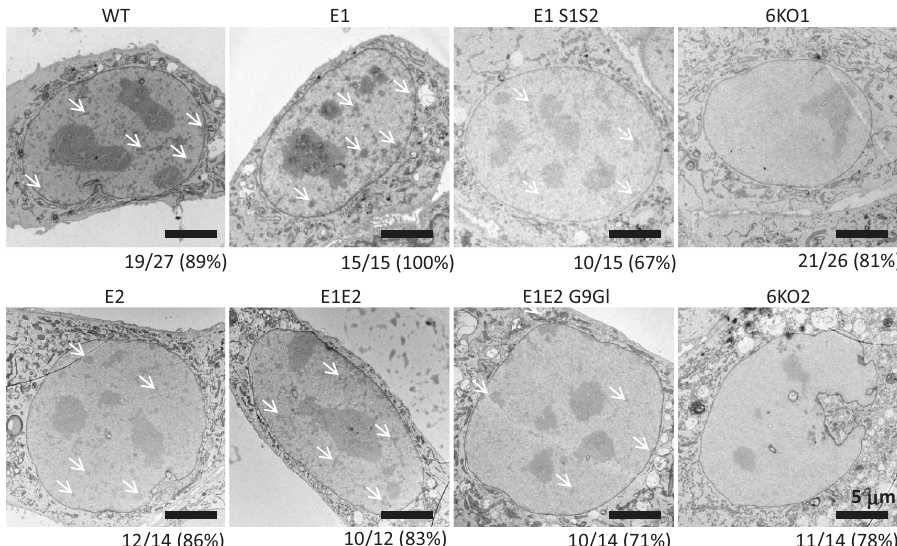
Fig. 7 Loss of electron-dense heterochromatin in MEF cells lacking all 6 SET-domain H3K9 KMT. Transmission electron microscopy (TEM) images of nuclei from compound H3K9 KMT mutants. Each panel shows a representative TEM image of a nucleus of the indicated H3K9 KMT mutant. White arrows point to electron-dense heterochromatin clusters. The total number of cells analyzed and the percentage of cells displaying the shown pattern are indicated below each image. Scale bars represent 5 μ